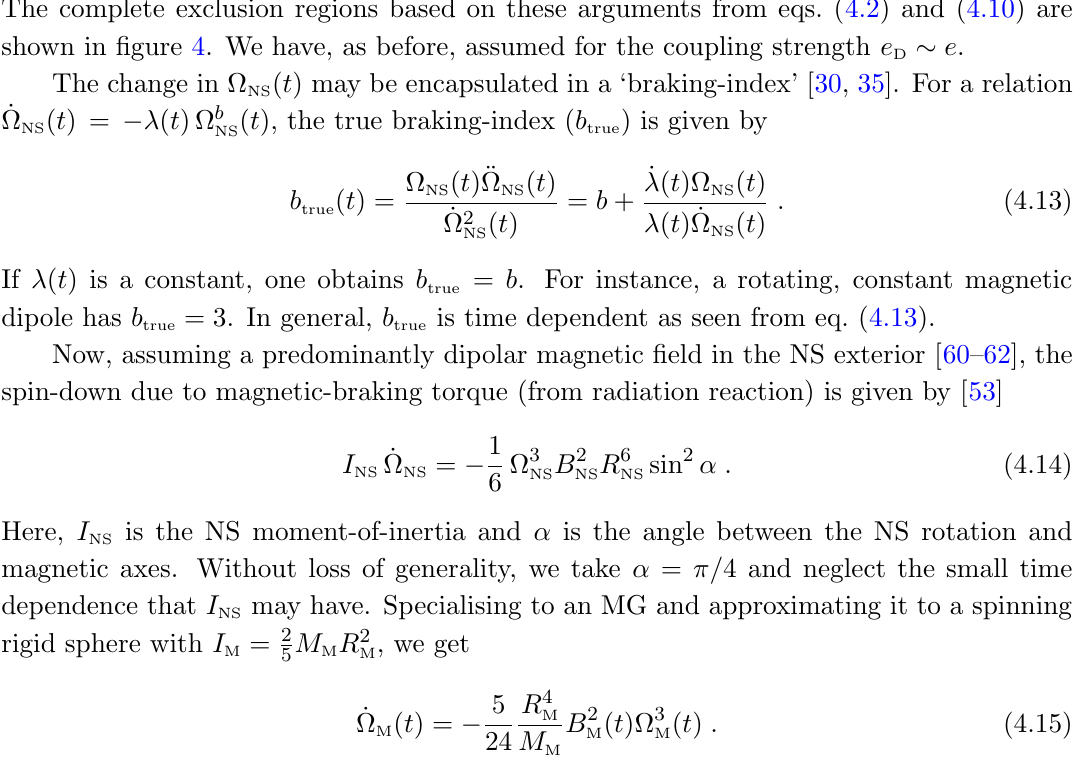
( t ) evolution arguments, from eqs. (4.2) M > F Coul. regions, or alternatively, for all regions if E D < F Coul. E D